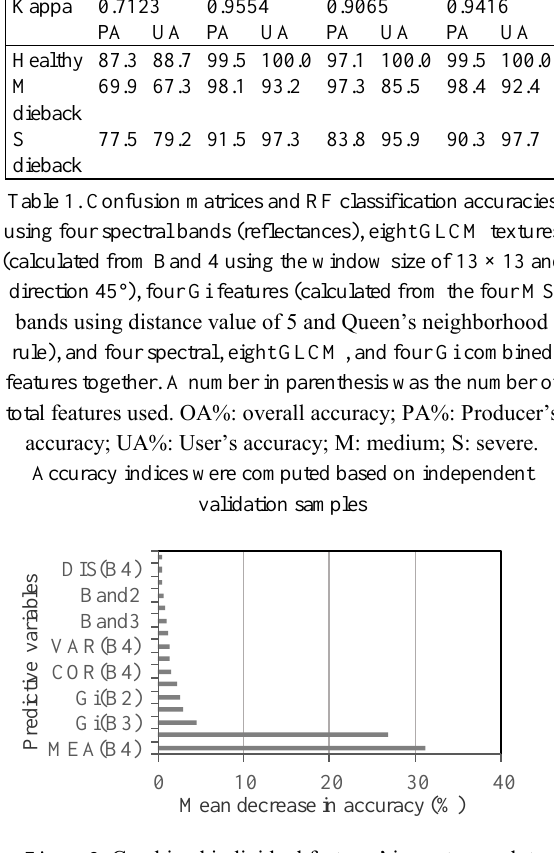
Figure 3. Combined individual features’ importance plot, expressed as mean decrease in accuracy (%) when a feature was left out in classification. B1, B2, B3, and B4 represent IKONOS blue band, green band, red band, and NIR band, respectively. The eight GLCM features were calculated from IKONOS Band 4 with the window size of 13 × 13 and direction 45°, and displacement 1 pixel. The Gi features were calculated from the four IKONOS MS bands with the distance value of 5